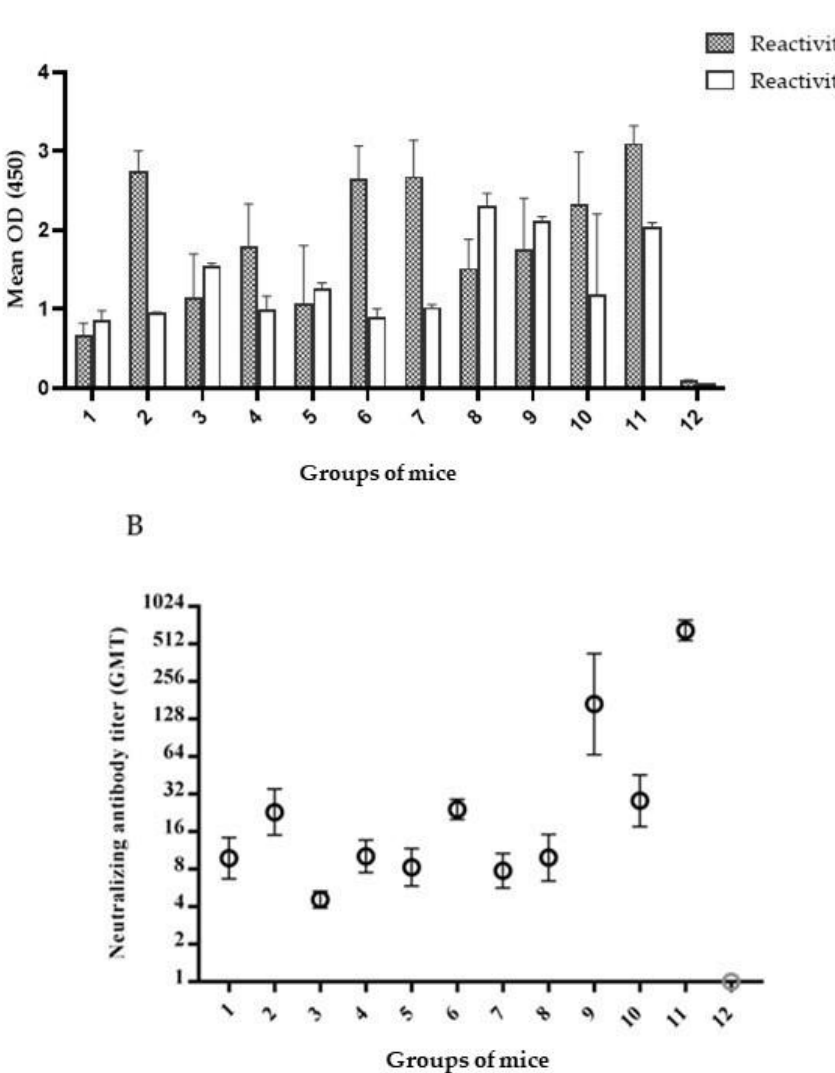
Figure 4. ( A ) Evaluation of the humoral response of immunized mice with different combinations of antigens, either against rGn or whole TOSV, by ELISA. ( B ) Evaluation of the neutralizing antibody response in immunized mice measured in quadruplicate. Results are reported as geometric mean titer (GMT, black circles) with 95% confidence interval (95% CI). Group 1 : peptide 1-KLH; Group 2 : peptide 2-KLH; Group 3 : peptide 3-KLH; Group 4 : peptide 1-KLH and peptide 2-KLH; Group 5 : peptide 1-KLH and peptide 3-KLH; Group 6 : peptide 2-KLH and peptide 3-KLH; Group 7 : peptide 1-KLH, peptide 2-KLH and peptide 3-KLH; Group 8 : pep GC683; Group 9 : pep GC683 and peptide 3-KLH; Group 10 : pep GC727; Group 11 : rGn; Group 12 : PBS.